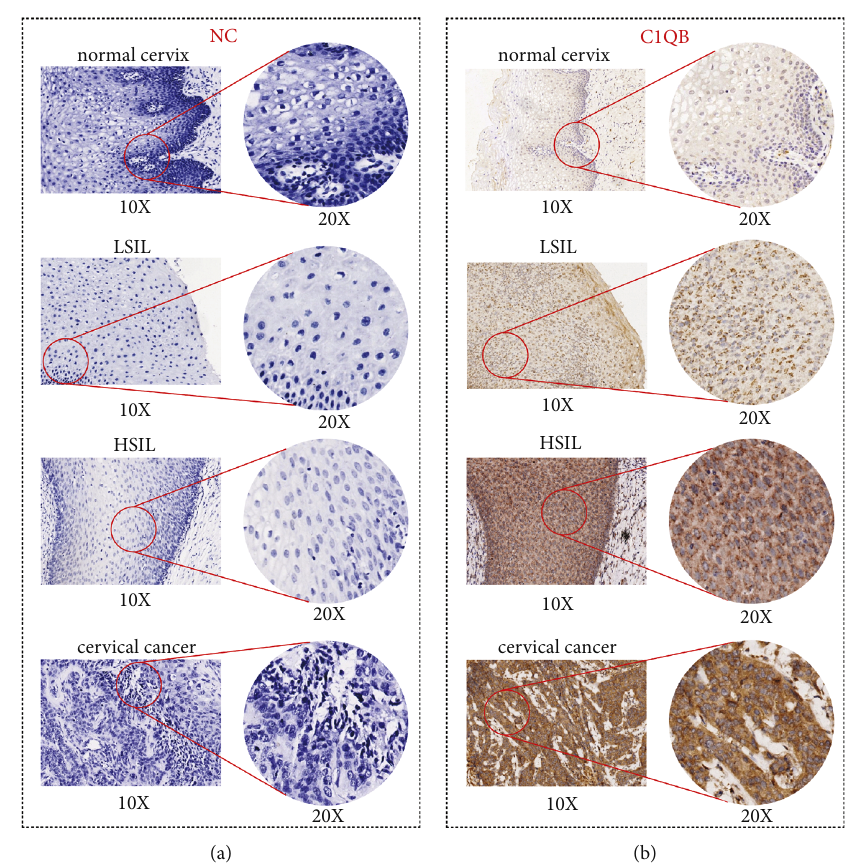
Figure 2: Images of immunohistochemical staining in benign cervical, LSIL, HSIL, and cervical cancer tissues. (a) Negative controls stained with PBS and (b) stained with anti- C1QB polycolonal antibody. LSIL, low-grade squamous intraepithelial lesions of cervix; HSIL, high-grade squamous intraepithelial lesions of cervix; NC, negative